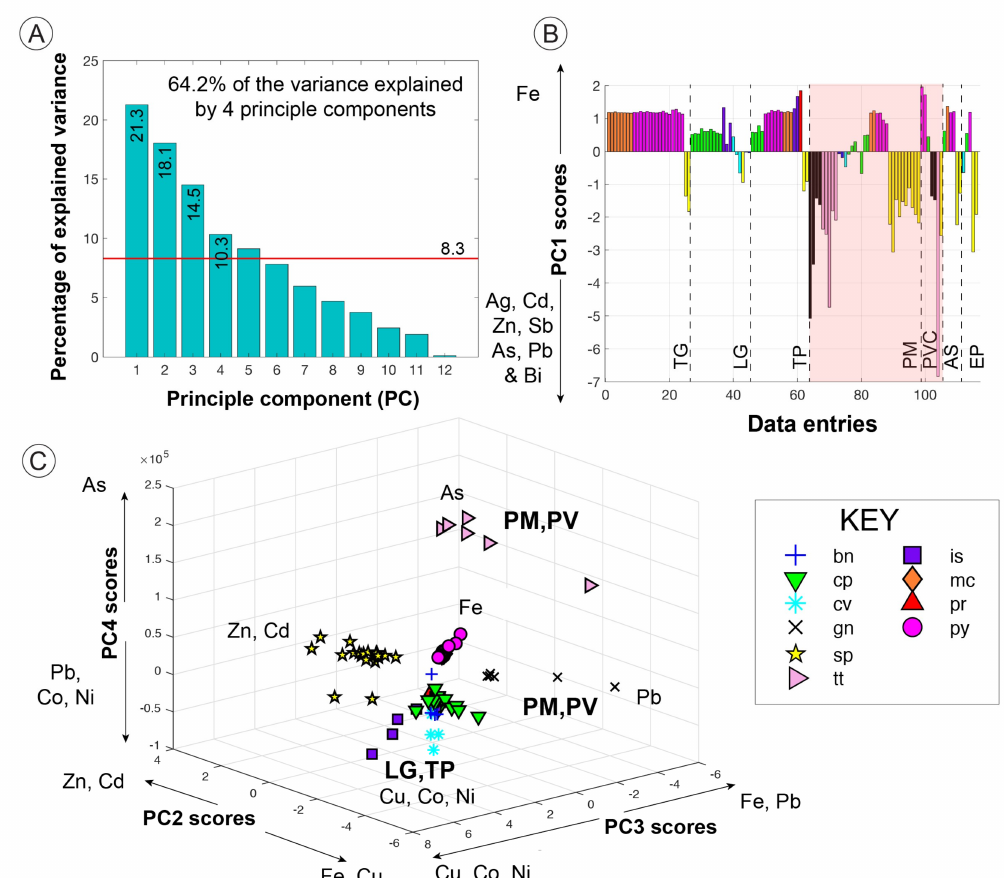
Figure 8. Principle component analysis (PCA) was undertaken across the z-scored LA-ICP-MS dataset including Fe, Cu, Zn, As, Sb, Pb, Cd, Mn, Co, Ni, Ag and Bi to identify principle components